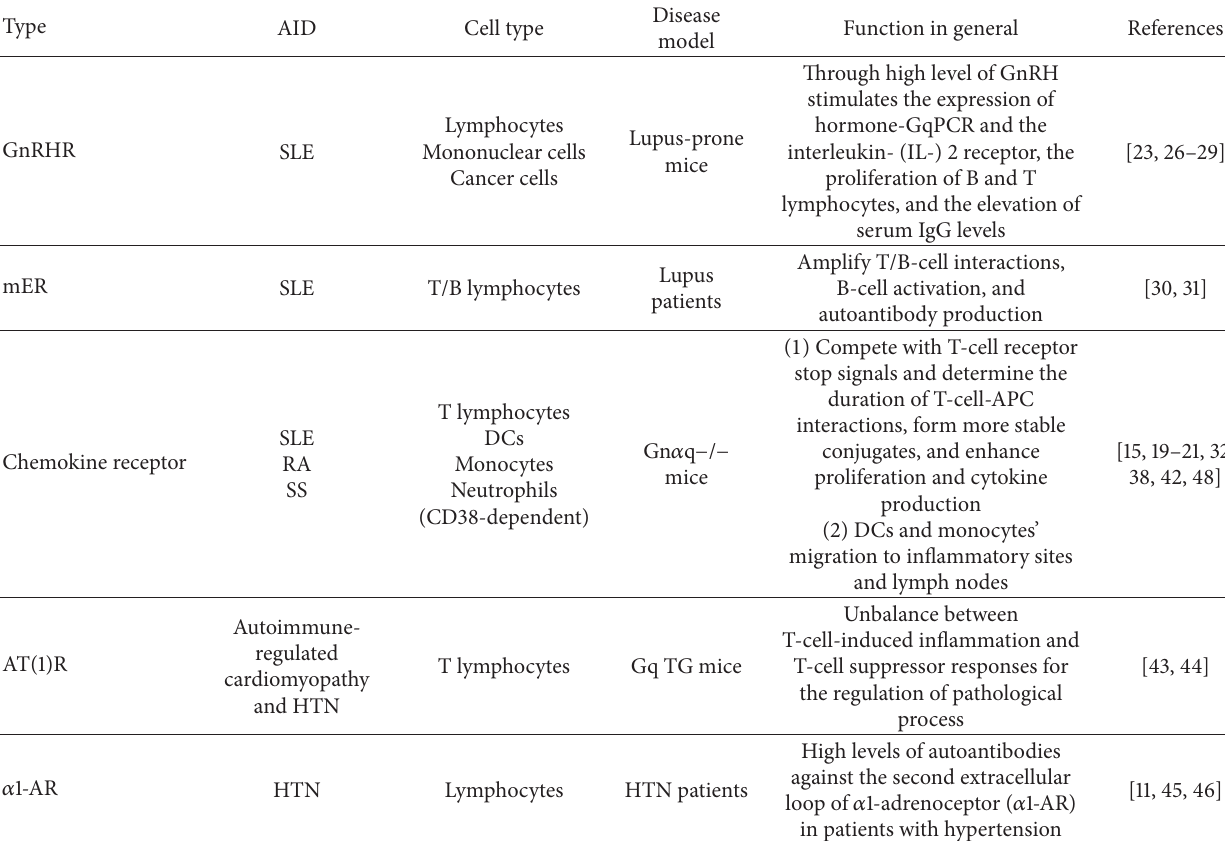
Table 1: Gq-coupled GPCRs in